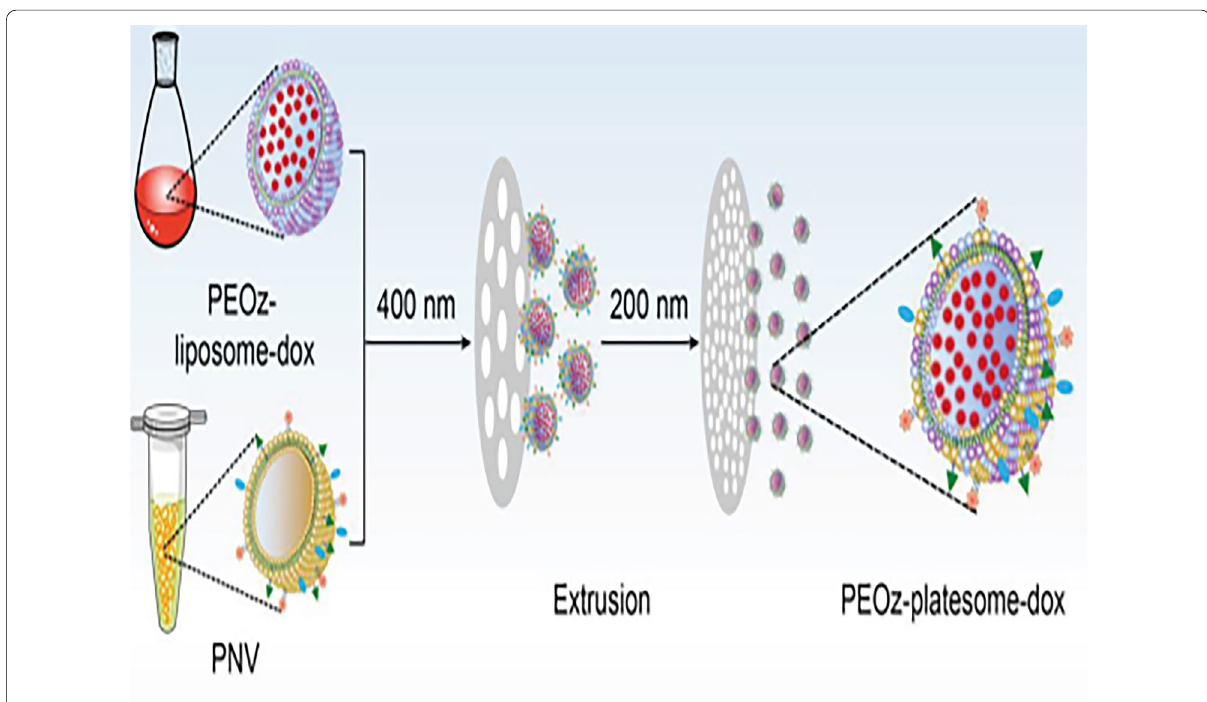
Fig. 2 Schematic illustration of the preparation of PEOz-platesome-dox. PEOz-platesome-dox was generated by coextrusion of PEOz-liposome-dox and PNV. Reprinted with permission from Ref. [14]. Copyright © 2019,